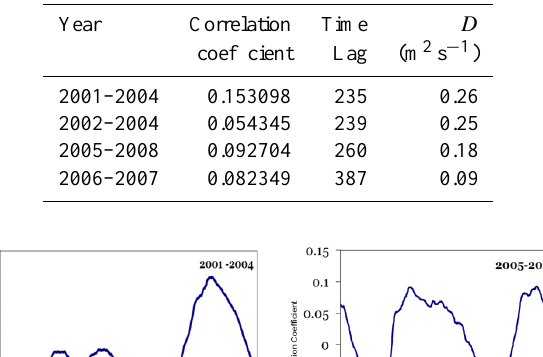
Table 2. The correlation coefficient, time lag and hydraulic diffu- sivity in different time intervals (years).